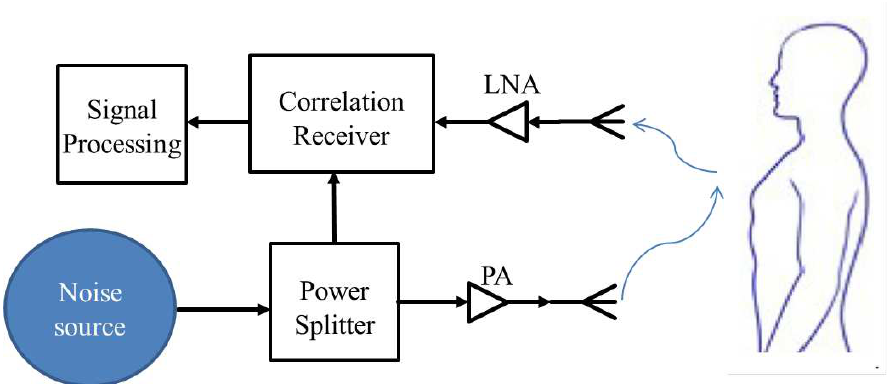
Figure 15. Diagram of a basic random noise UWB radar sensor.